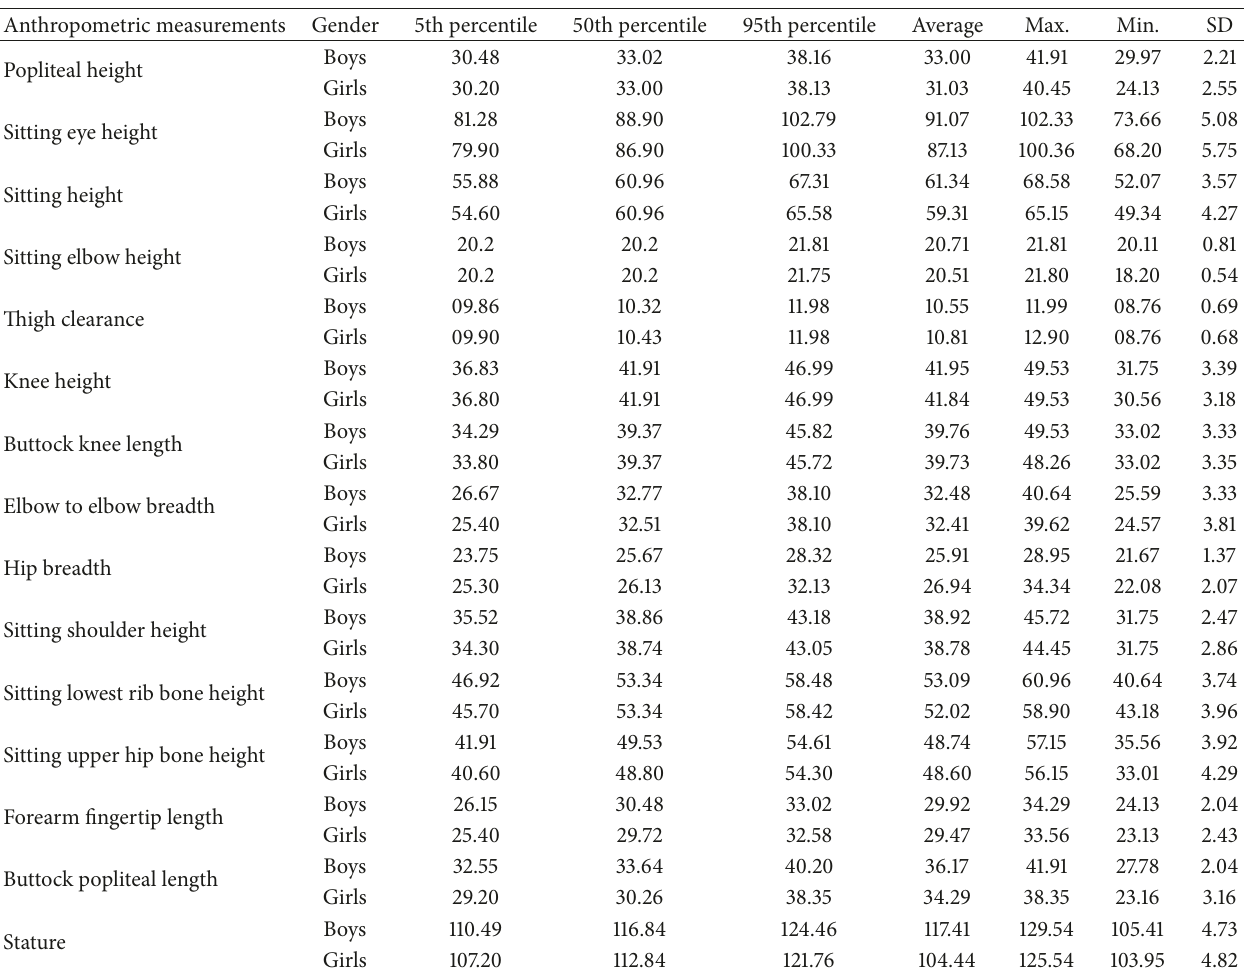
Table 1: Anthropometric measures of students (cm) by